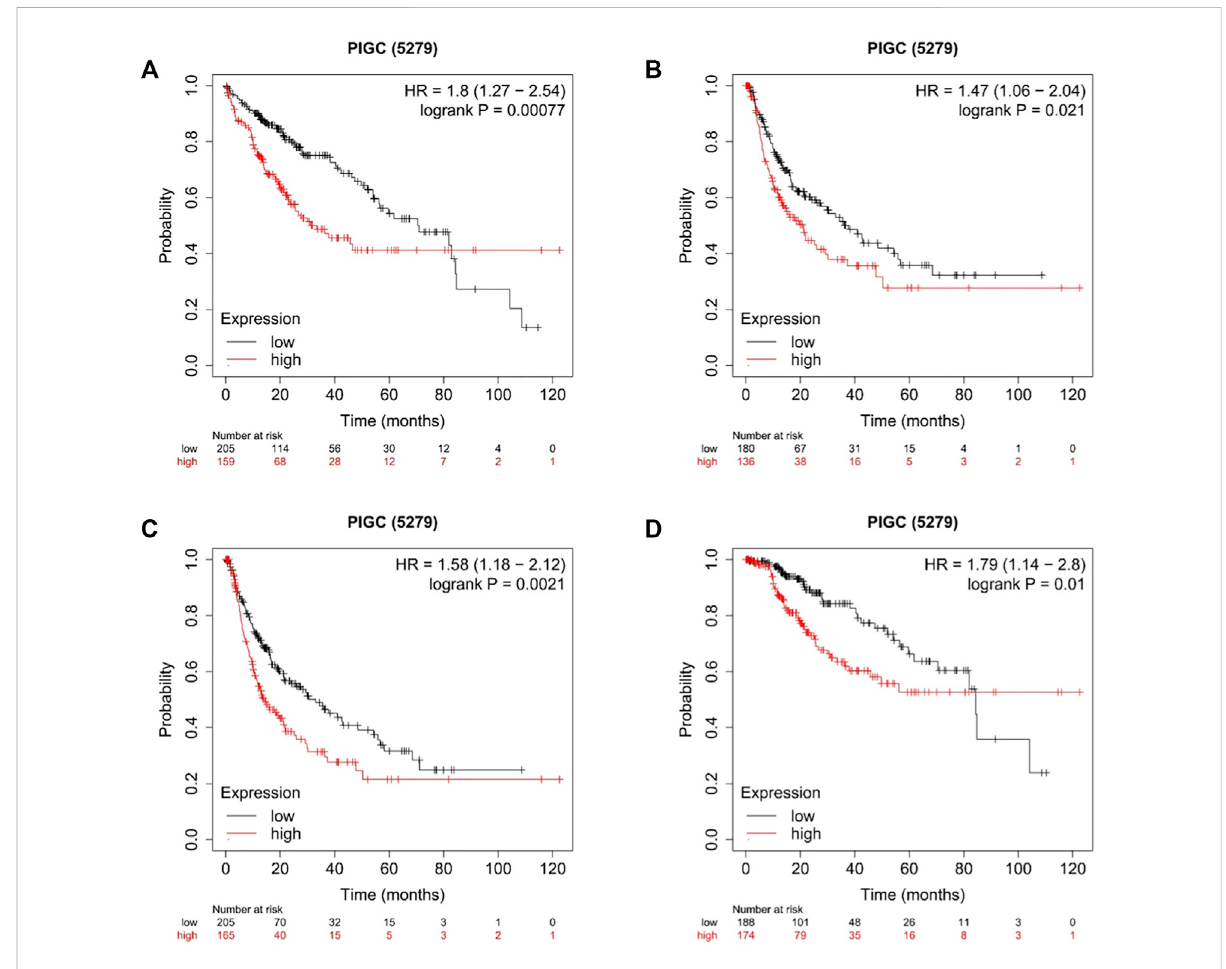
FIGURE 4 Kaplan – Meier plot of theCorrelation of PIGC Expression and Patient Survival inHCC (A) Overall survival (OS). (B) Recurrence freesurvival (RFS). (C) Progression Free Survival (PFS). (D) Disease Free Survival